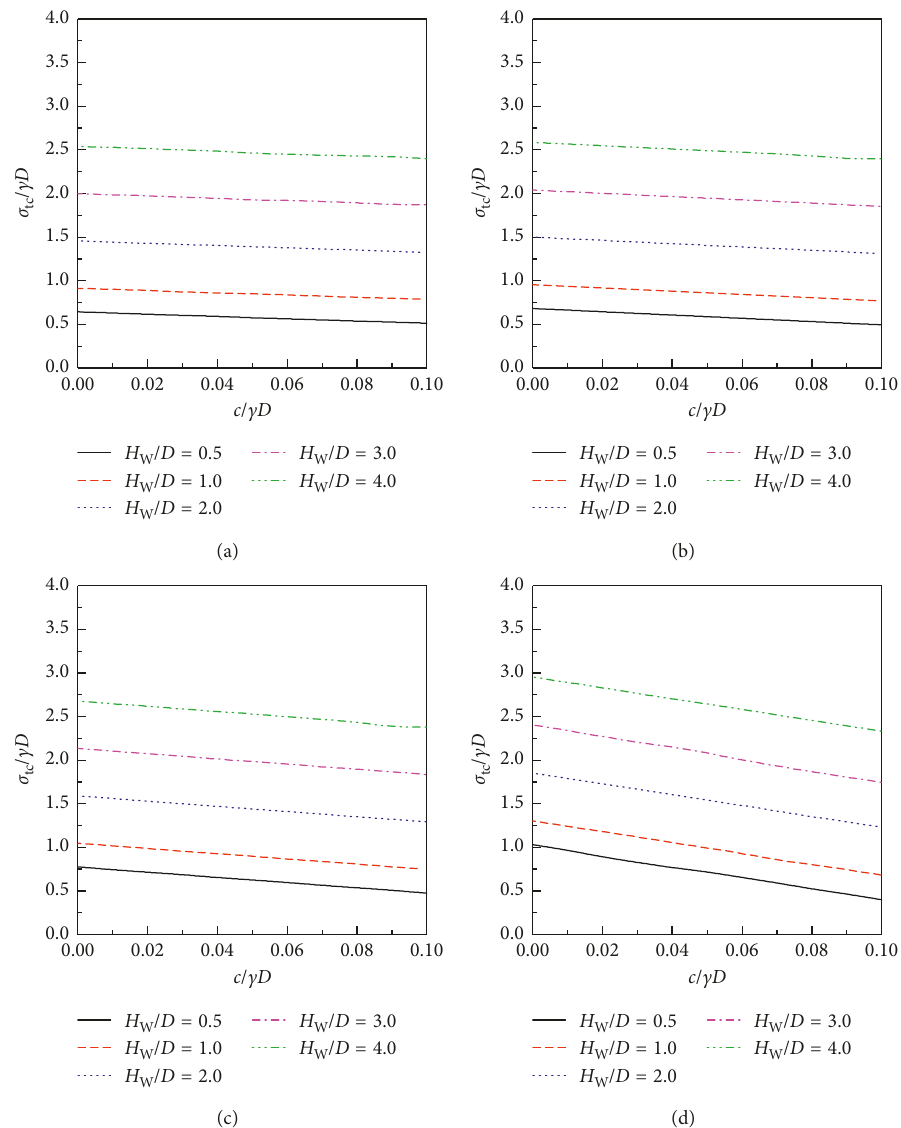
Figure 14: Stability charts of the critical pressure supported on the tunnel face under the pore water pressure r (c) φ 20 ° . (d) φ 10 ° (cid:29) (cid:29)